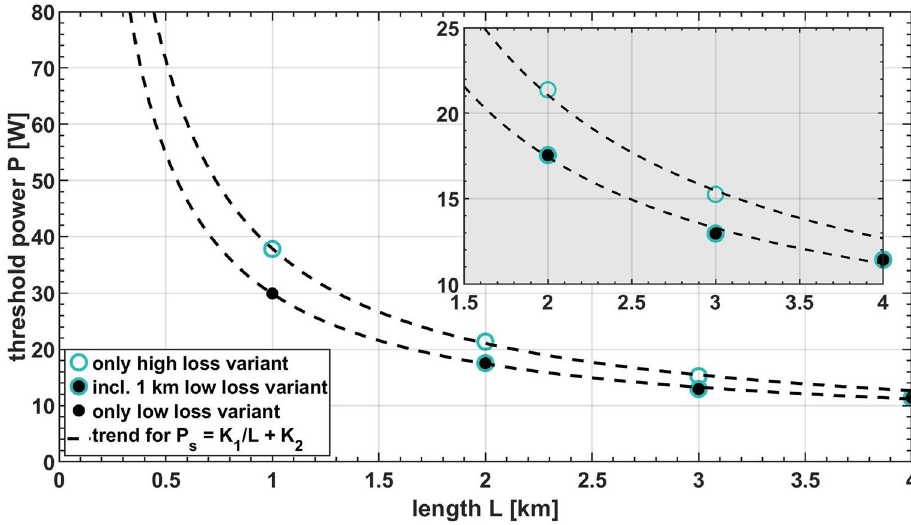
Figure 5. DI threshold power as a function of passive fiber length and loss. The inset highlights the power difference between two trends.